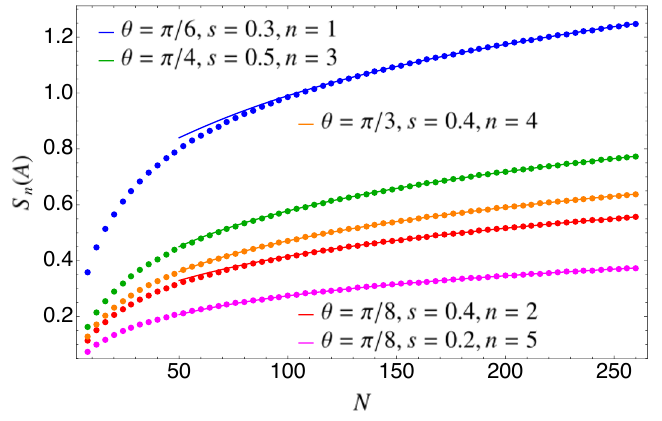
Figure 1 . The Rényi entropies S n ( A ) for 4 bosonic species with M A = 2 . We choose different values of s, θ, n and we plot it as a function of the number of sites N . The lines show the curve C n ( s, θ ) log N + b 0 + b 1 N − 1 /n where the coefficients b i are fitted using the data for N ≥ 100 . The coefficients C ( s, θ ) are obtained by summing over the single-wire results, as explained in eq. n